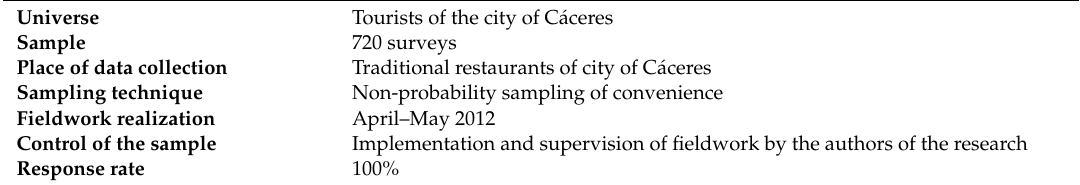
Table 2. Technical details of the